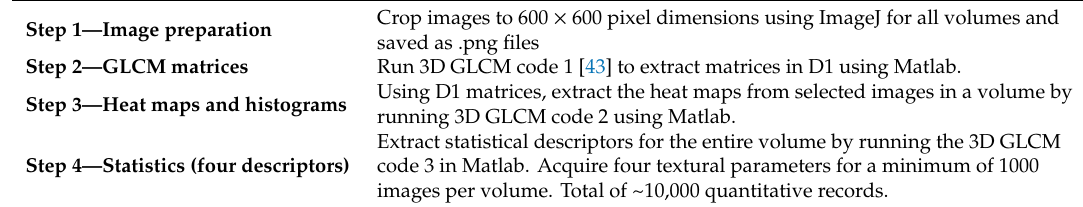
Table 3. 3D GLCM image analysis methodology. Each step was applied to every XCT scan to generate the GLCM